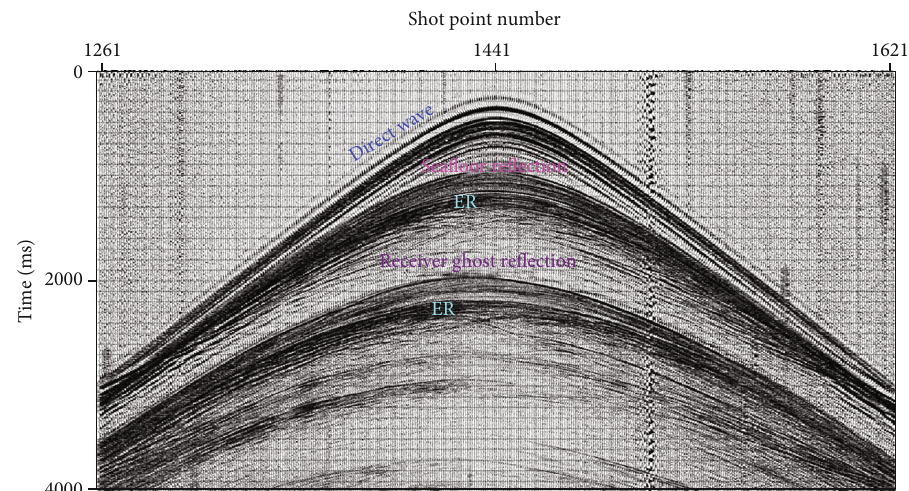
Figure 3: The fi ltered receiver gathers from the shallowest hydrophone.